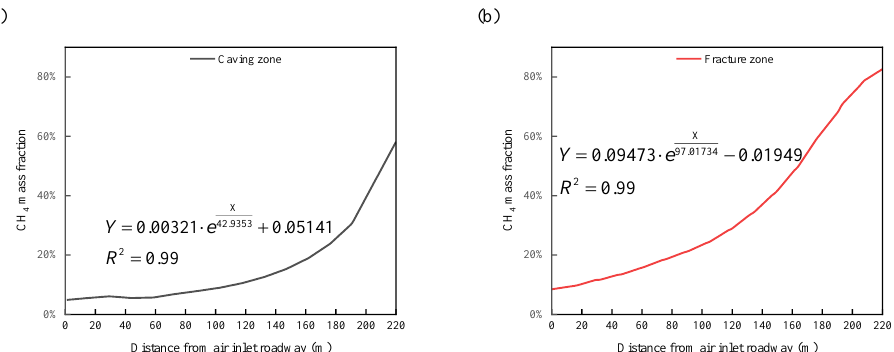
Figure 13. Variation curve of gas mass fraction in the inclination direction of the control group ( a ) caving zone ( b ) fracture zone.